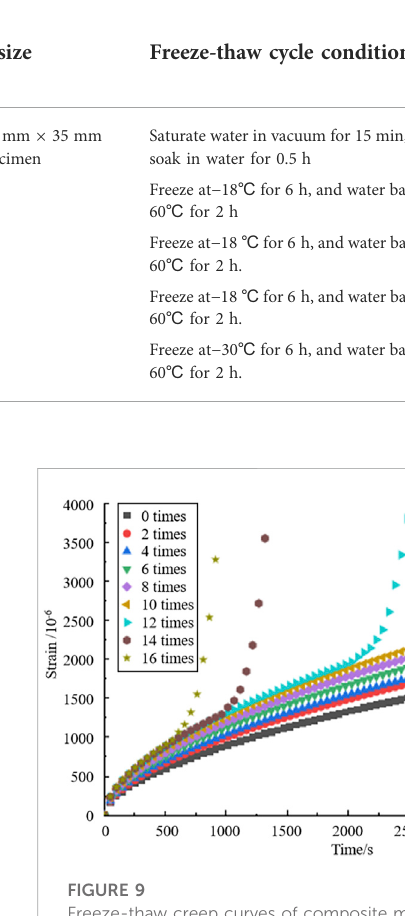
FIGURE 9 Freeze-thaw creep curves of composite modi fi ed OGFC at mixing ratios of (12%,0%).